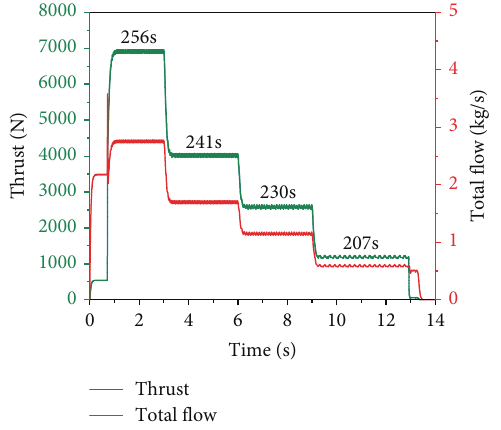
Figure 17: Thrust/speci fi c impulse and total fl ow change in the process of variable thrust.